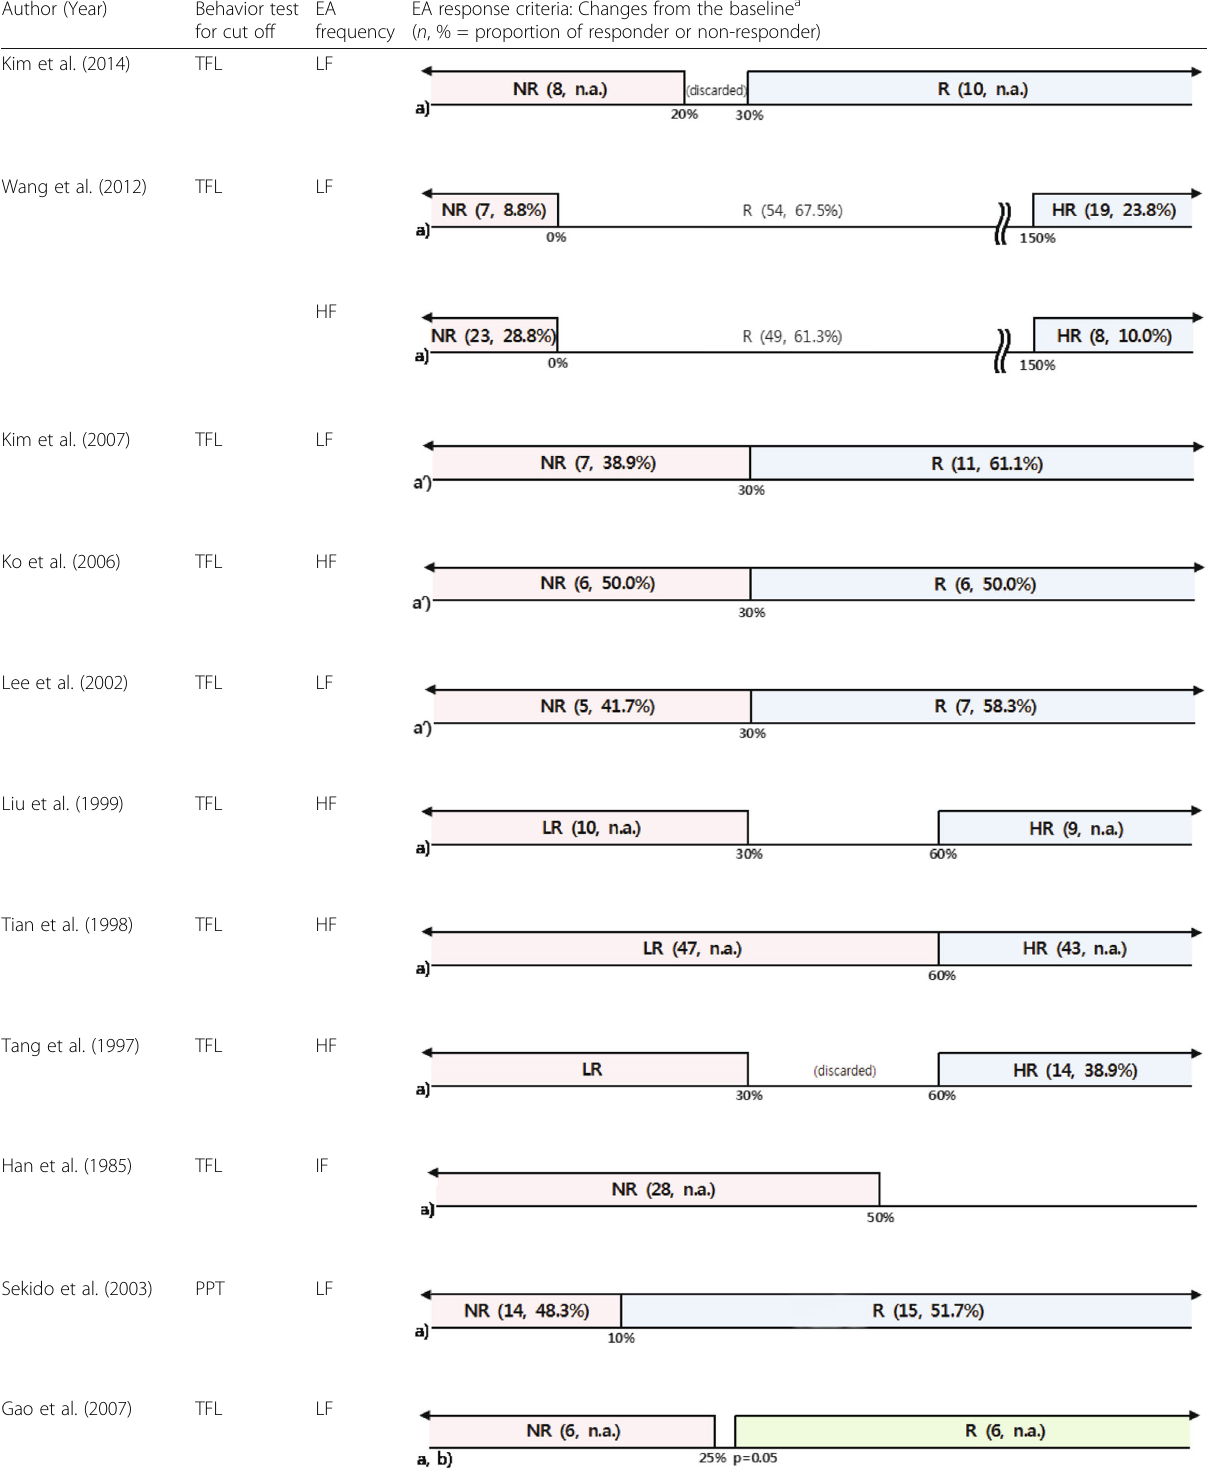
Table 3 EA response criteria and associated